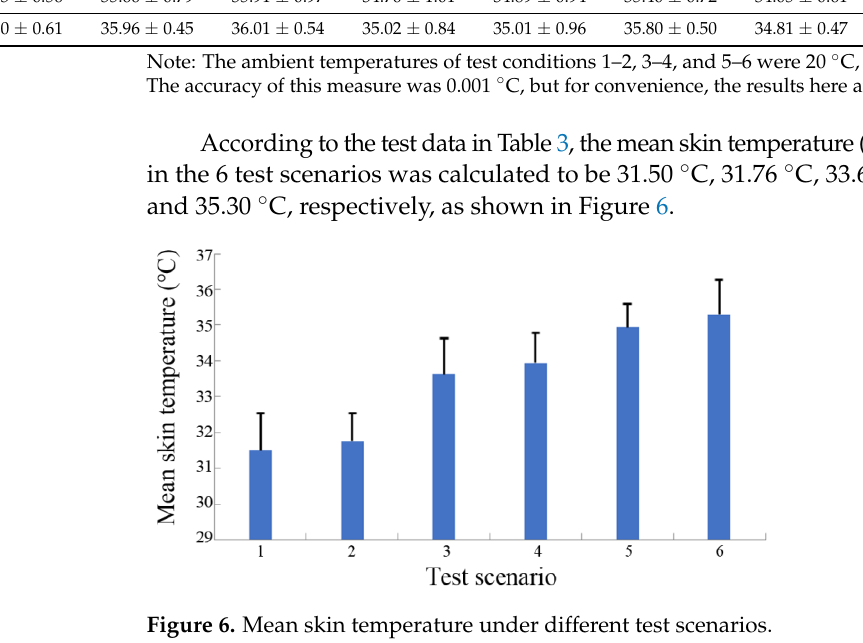
Figure 6. Mean skin temperature under different test scenarios.